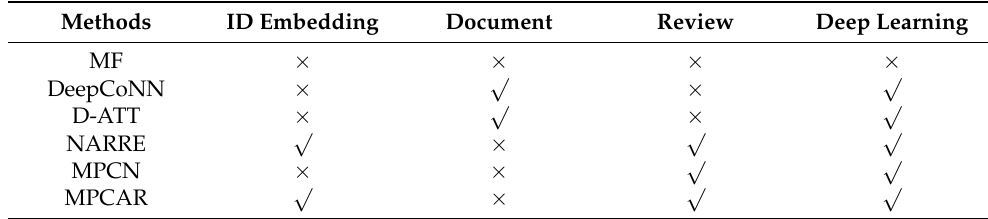
Table 3. Comparison